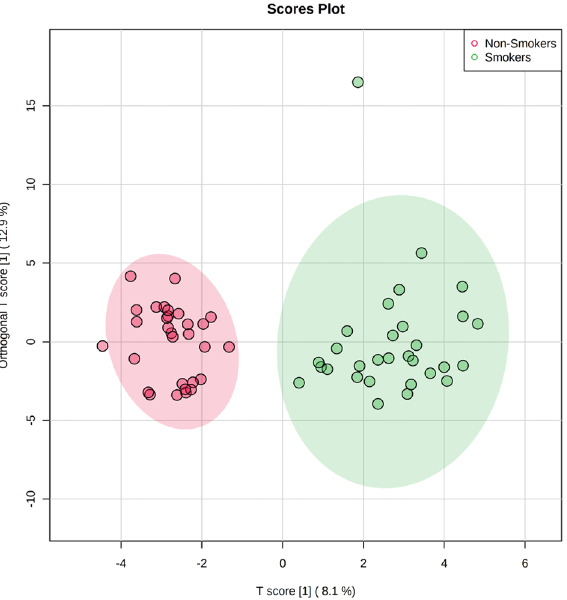
Figure 1. A well-defined alteration in the metabolomic profile of medwakh smokers was noticed using sparse partial least squares-discriminant analysis (sPLS-Da). The color red denotes non-smokers, while the color green denotes medwakh smokers.